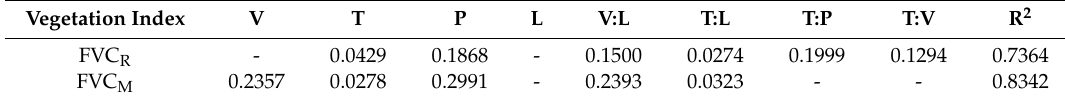
Table 4. The parts of each factor in R 2 of the fitting